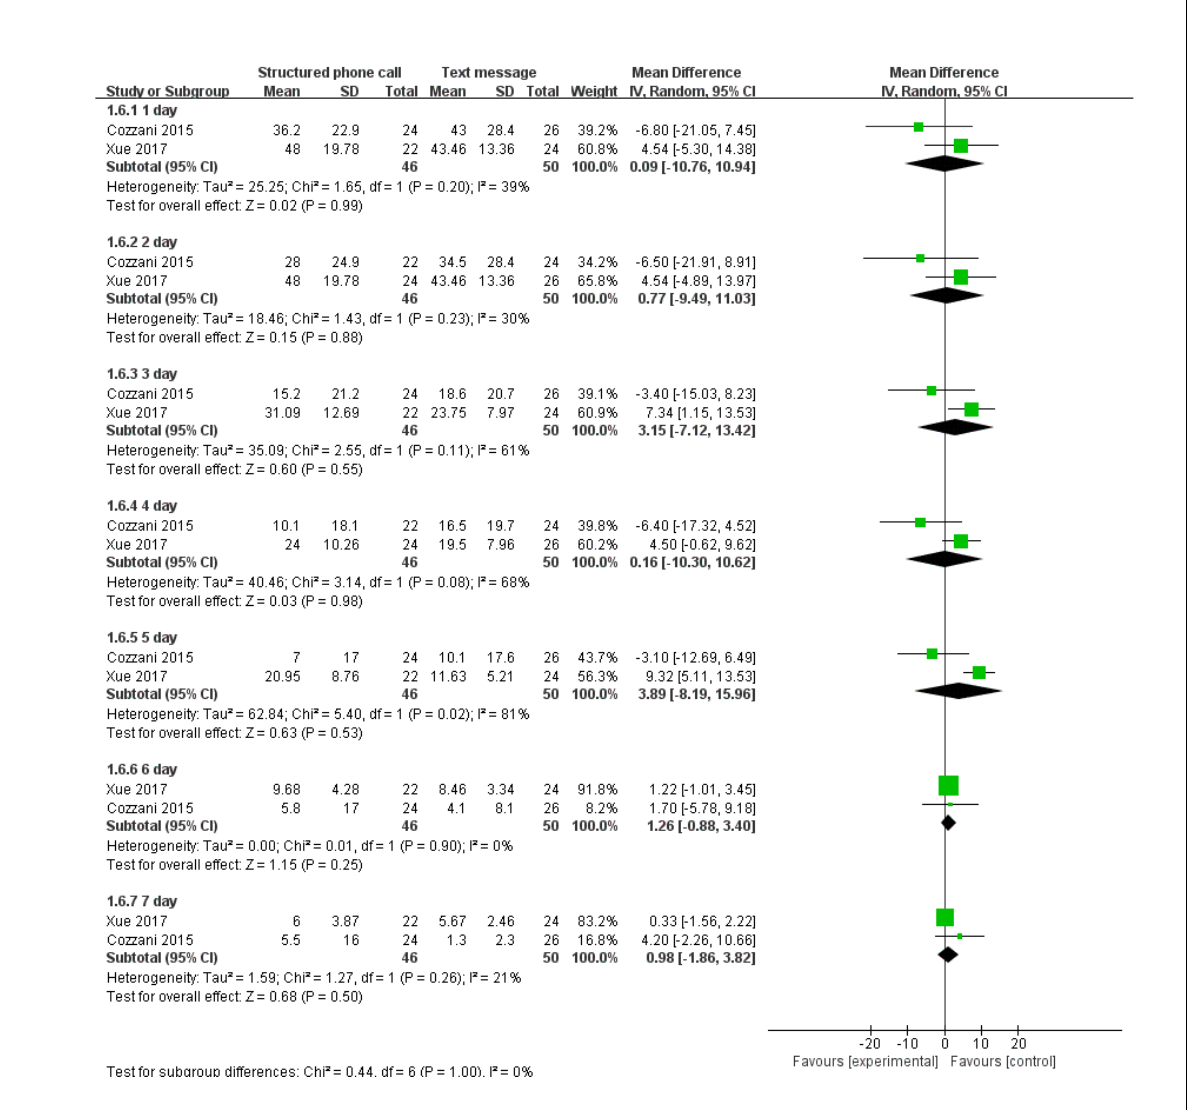
both interventions’ pain reduction effectiveness is similar daily within a week after activation of